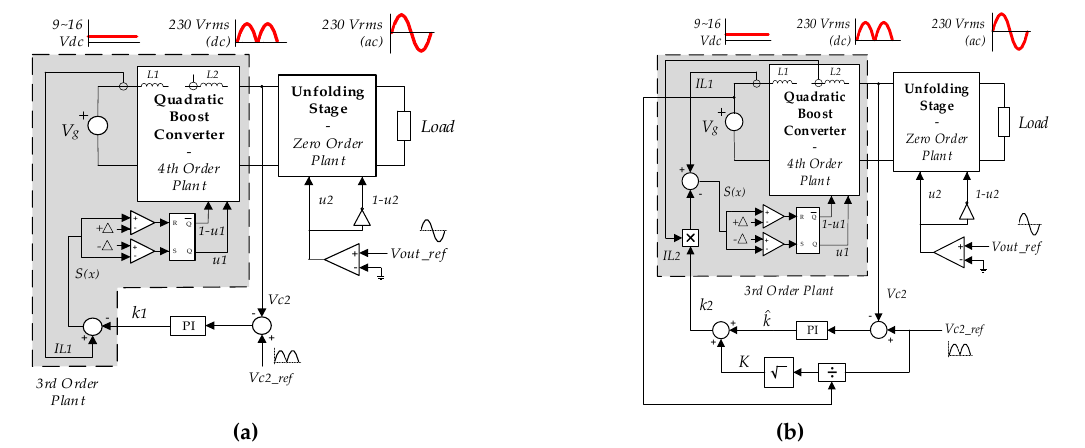
Figure6. Outputvoltageregulation. Proposedslidingsurfaces: ( a Figure 6. Output voltage regulation. Proposed sliding surfaces: ( a ) using the microinverter input current 1